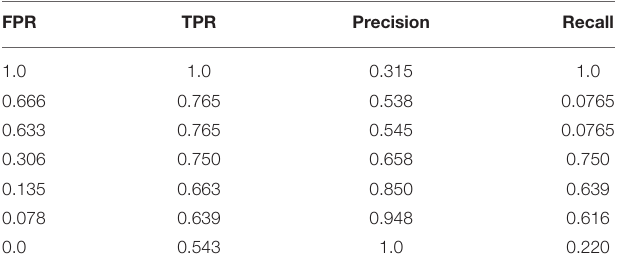
TABLE 2 | Quantitative analysis of anomaly network in terms of False-Positive Rates (FPR) vs. True-Positive Rates (TPR) (left) and Precision vs. Recall (right) averaged over various anomalous activities.